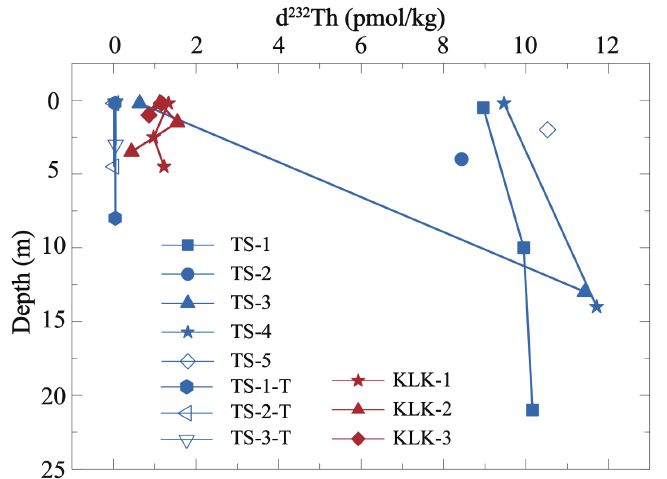
Figure 3. Distribution features of dissolved 232 Th concentration in the depth profiles of Tuosu Lake and Keluke Lake.